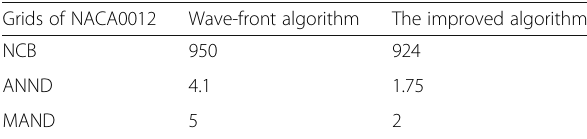
Table 2 Comparison between wave-front algorithm and its improvement Grids of